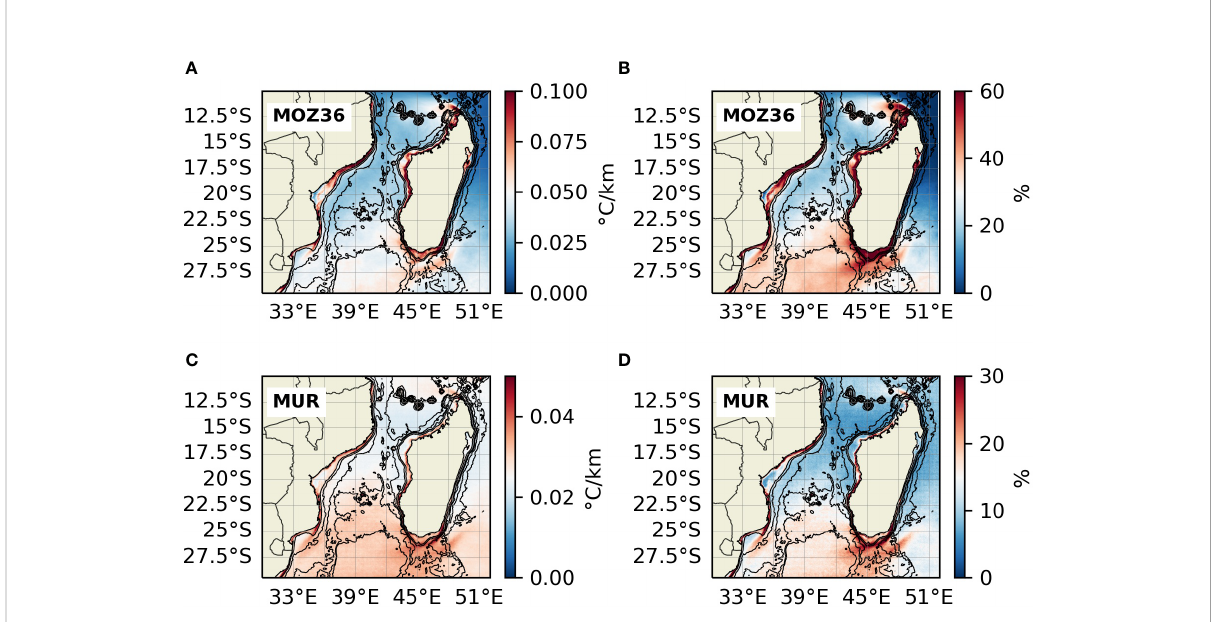
FIGURE 2 Mean surface temperature front intensity (A, C) and probability (B, D) for MOZ36 (A, B) and MUR SST (C, D)